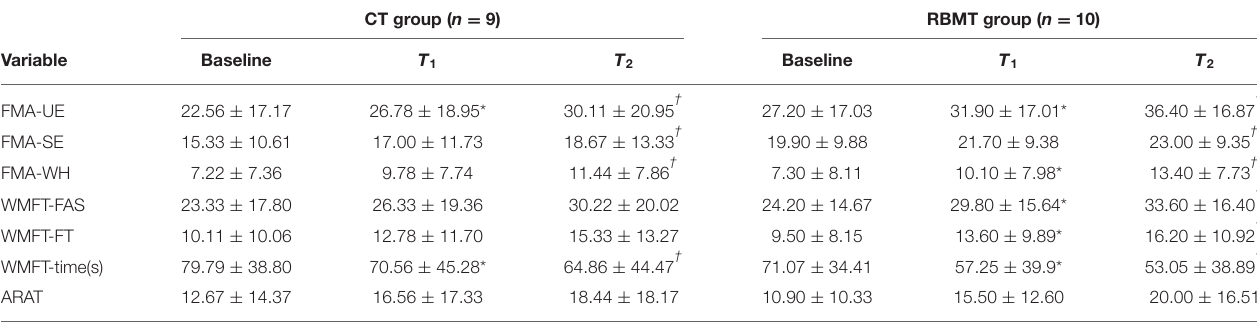
TABLE 2 | Within-group comparisons of clinical assessment scores.